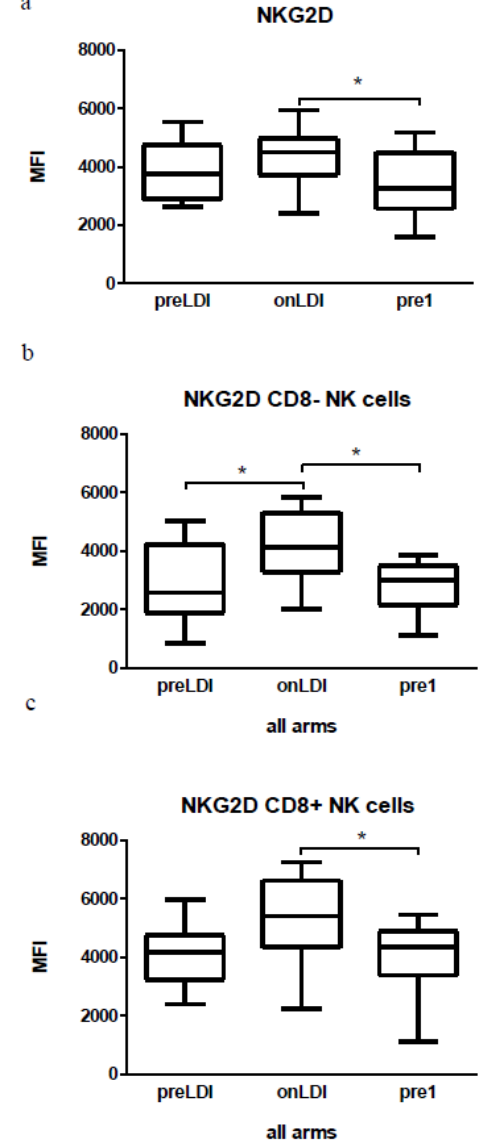
Figure 3. FACS analysis of NK cells and their activation state in the peripheral blood of patients. NK cells: expression of NKG2D on the surface of all CD45 + CD56 + cells ( a ); CD45 + CD56 + CD8 − cells ( b ) and CD45 + CD56 + CD8 + cells ( c ) during the course of IFN therapy. The immunological parameters of 17 patients were analyzed, * p <